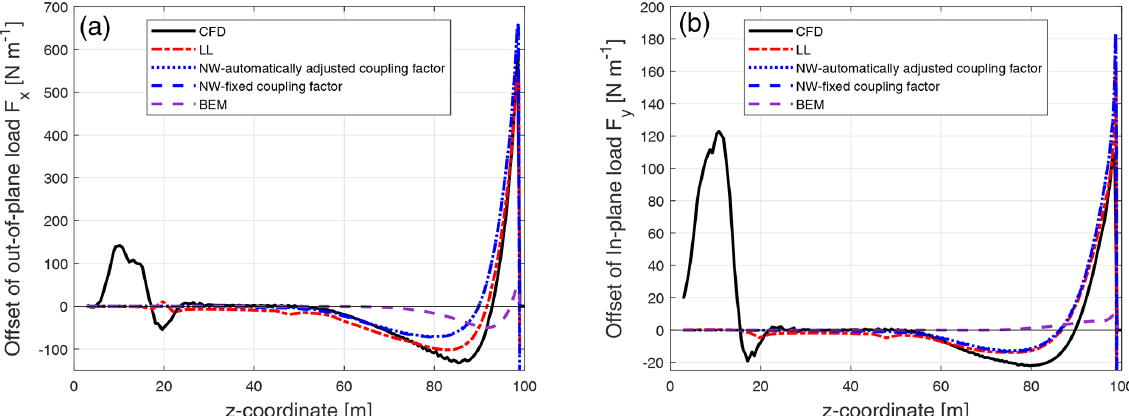
Figure C1. Comparison of the difference between the out-of-plane load (a) and the in-plane load (b) of the backward swept Blade-2 with respect to the baseline blade calculated from the Navier–Stokes solver (CFD), the lifting-line method (LL), the proposed coupled method (NW) and the blade element momentum method